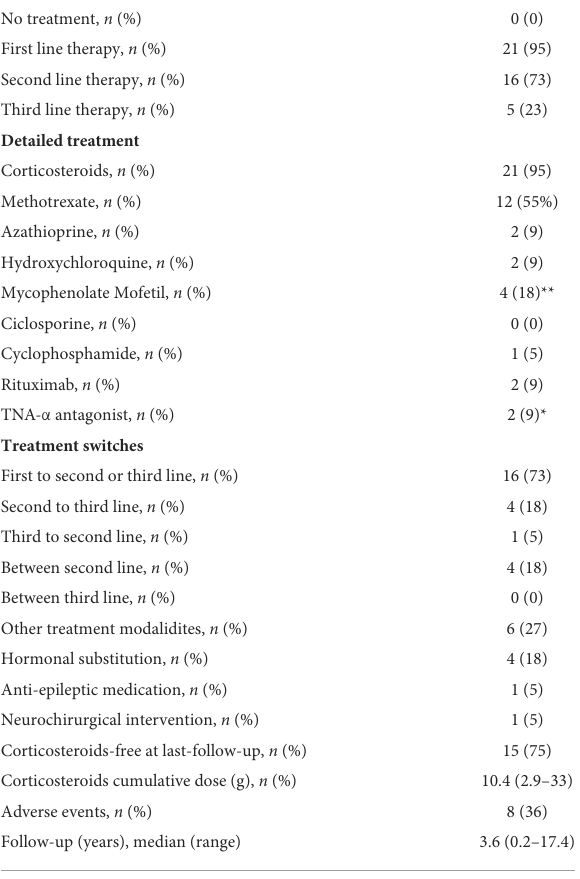
TABLE 5 Detailed treatment of our patient